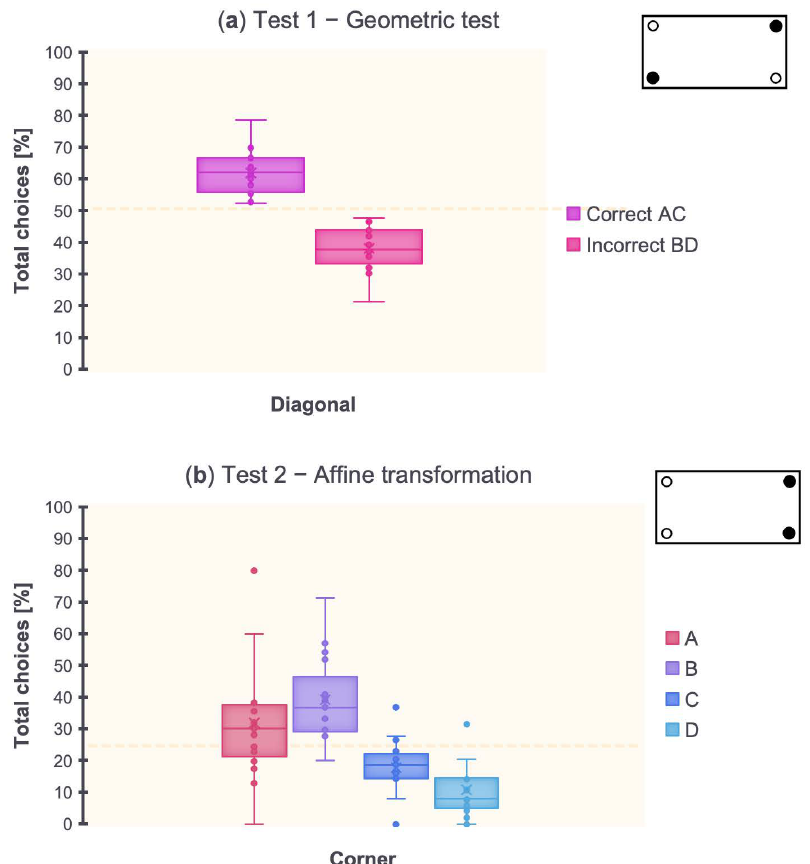
Figure 4. Results. ( a ) Total choices [%] toward the arena’s two diagonals (AC, BD) in the Test 1— Geometric test (blue wall removal). The dotted line indicates the chance level (50%). ( b ) Total choices [%] toward the four corners (A, B, C, D) in the Test 2—Affine transformation (blue wall 90 ◦ right switch). The dotted line indicates the chance level